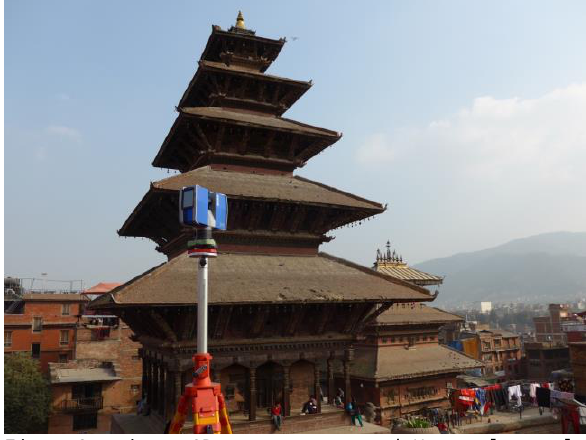
Figure 2: using a 3D scanner to record Nyatapola temple, Bhaktapur, Nepal.